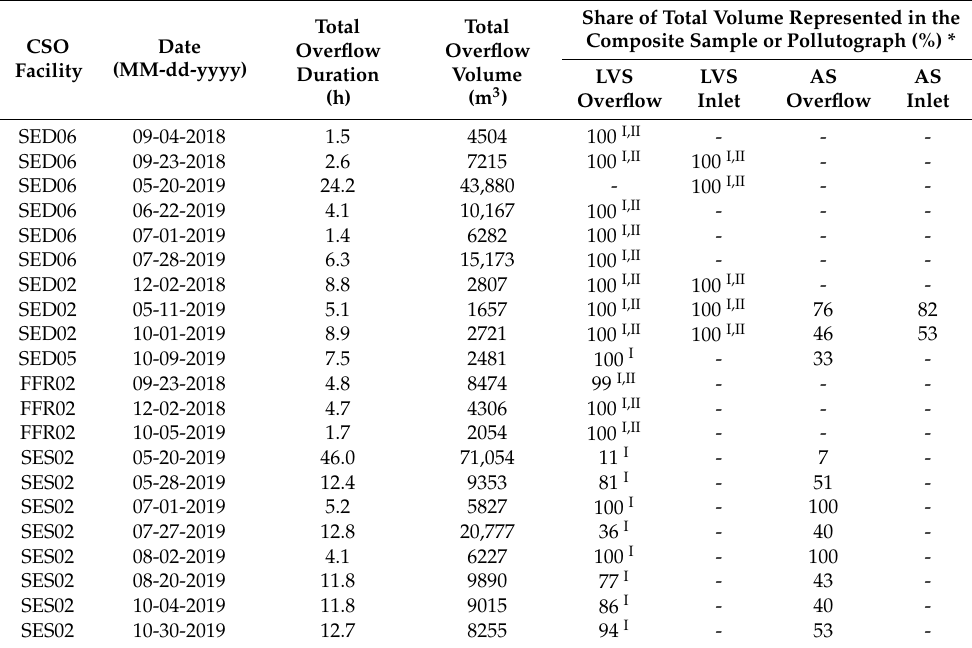
Table 2. Events sampled with large-volume samplers (LVS) or autosamplers (AS) at the inlet or overflow of combined sewer overflow (CSO)